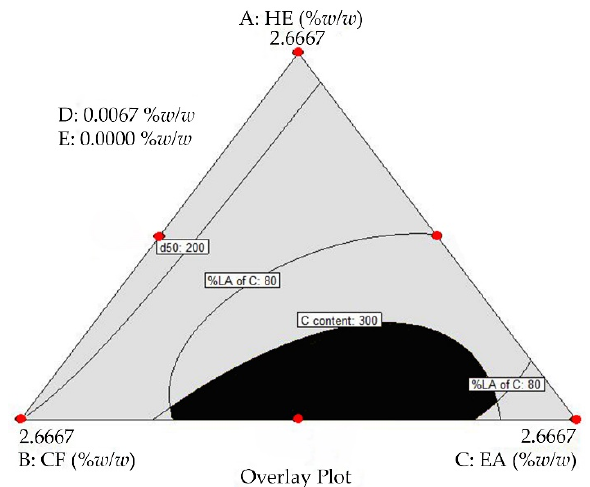
Figure 3. Overlay plot. Black area = the optimal region; A = HE; B = CF; C = EA; D = external curcumin; and E = sodium hyaluronate (NaHA). Lines represent the TE-NPs formulations with minimum and maximum dependent variable values according to the acceptance limit. The spots ( ● ) represent the design points.